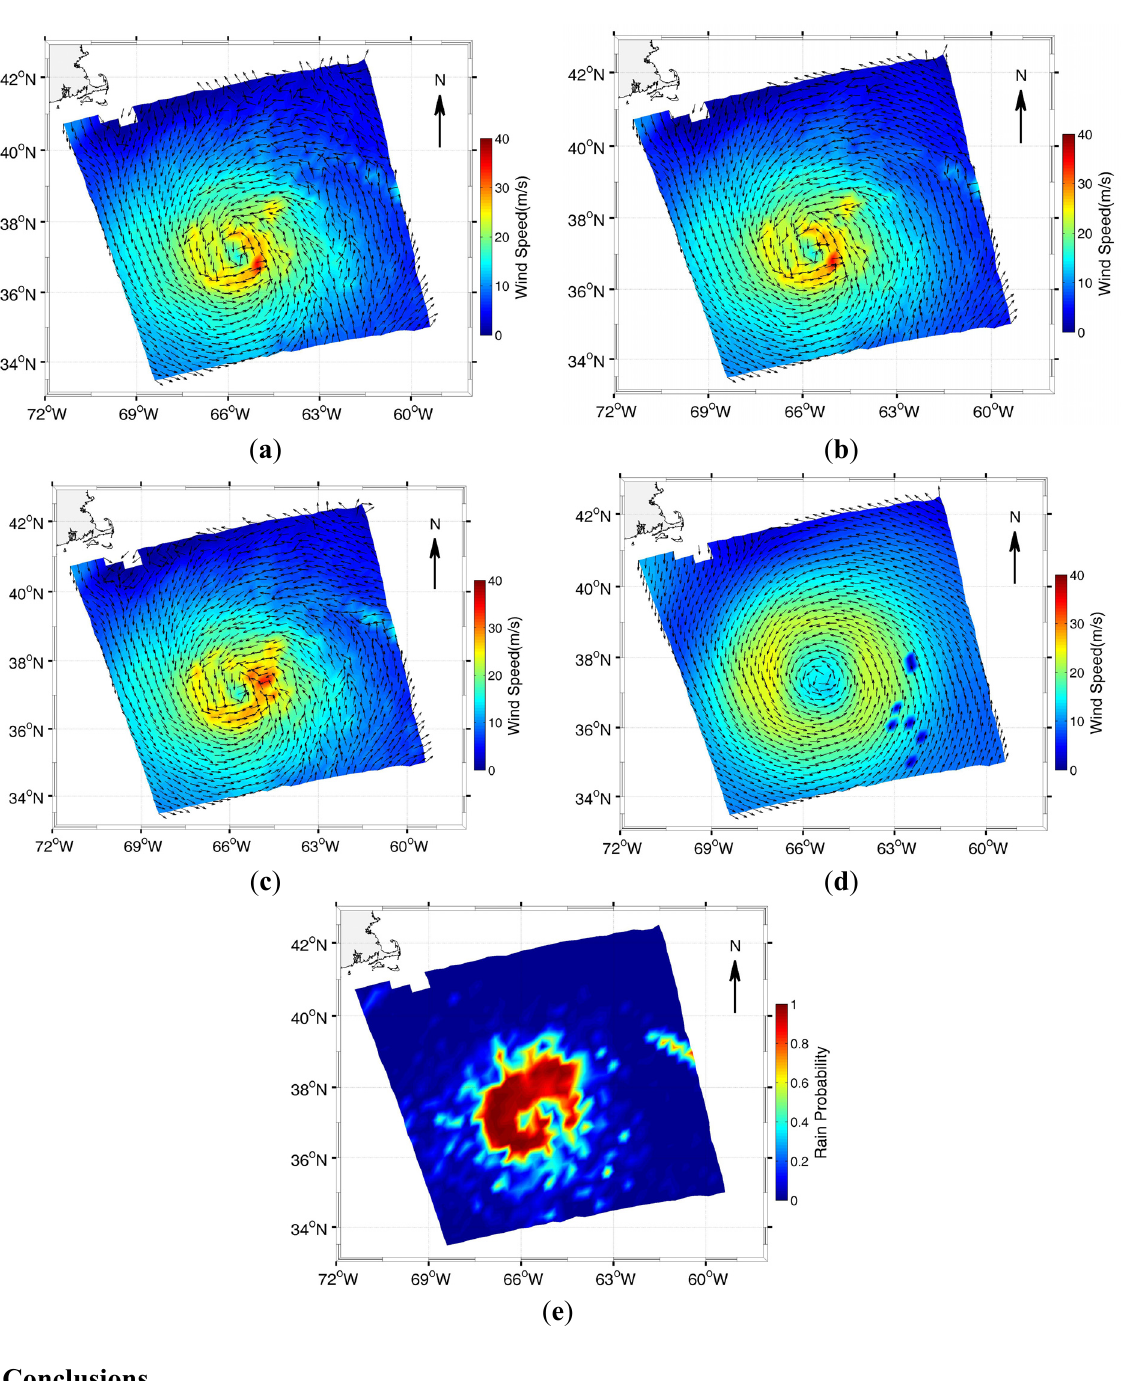
Figure 8. Another example of a cyclonic wind field of Hurricane Erin ( a ) retrieved by the traditional WSSD algorithm; ( b ) retrieved by the integrated algorithm; ( c ) the SeaWinds L2B wind; ( d ) the NWP wind; and ( e ) the image of rain